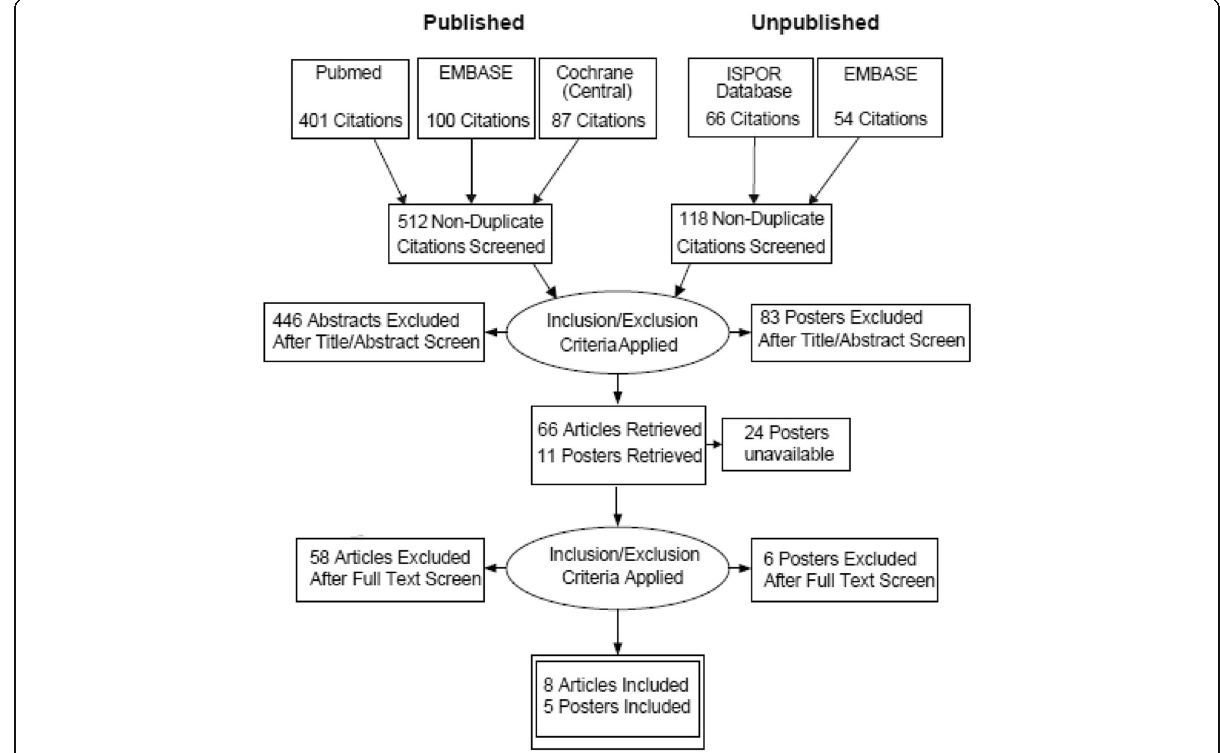
Fig. 1 PRISMA flow chart for results of search for published and unpublished